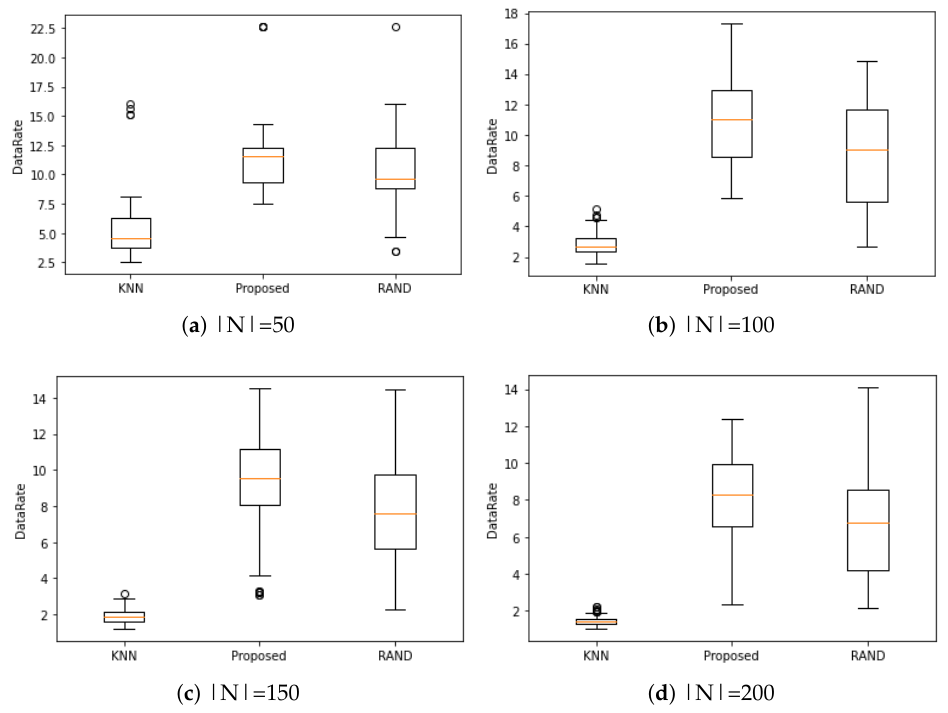
Figure 3. Comparison of the data rate provided to a WBAN.